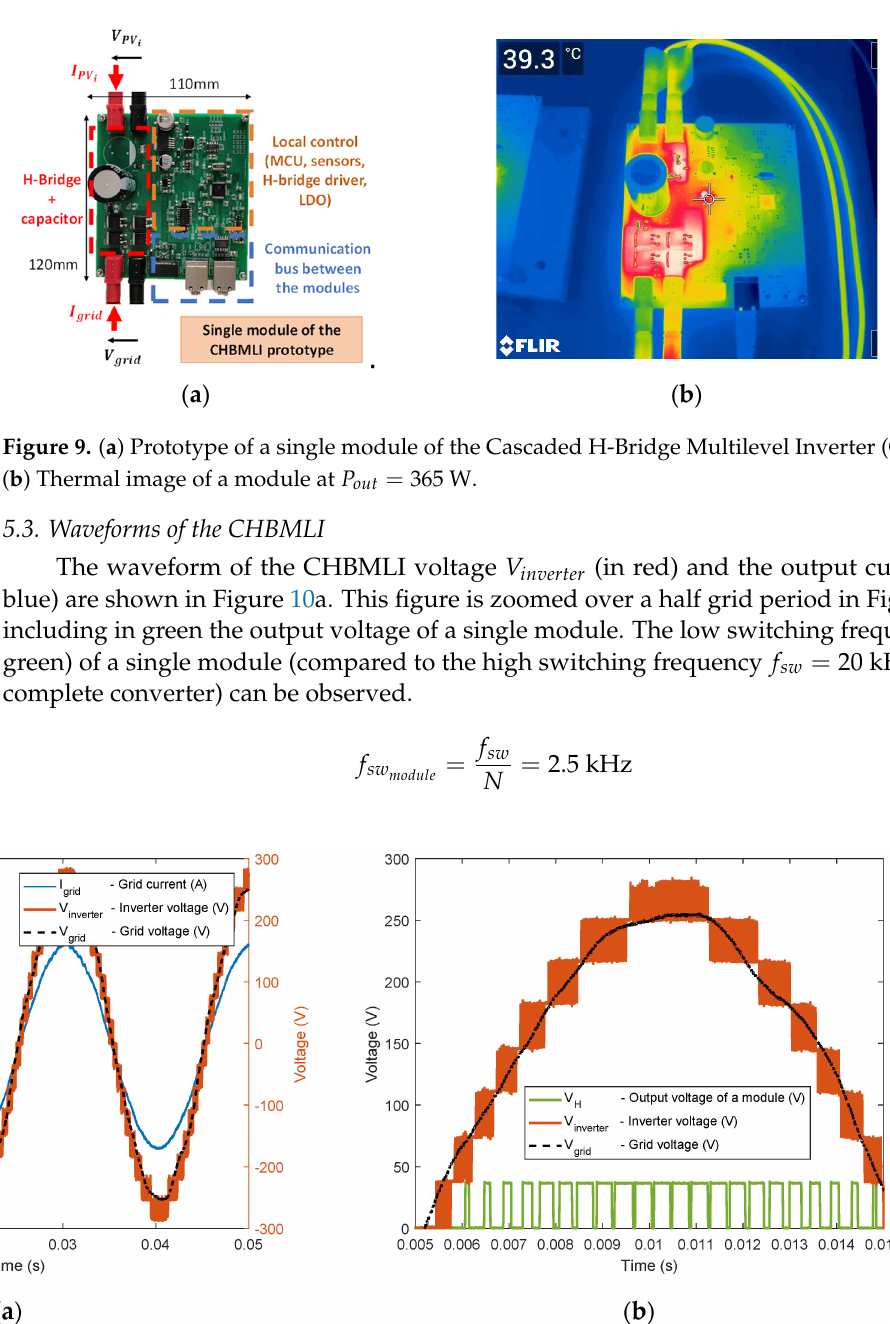
Figure 10. ( a ) Waveforms of the CHBMLI with I grid I grid (blue), Inverter Voltage V inverter (red), Grid voltage V grid (black) ( b ) Same as ( a ) but including the output voltage of a single module V H